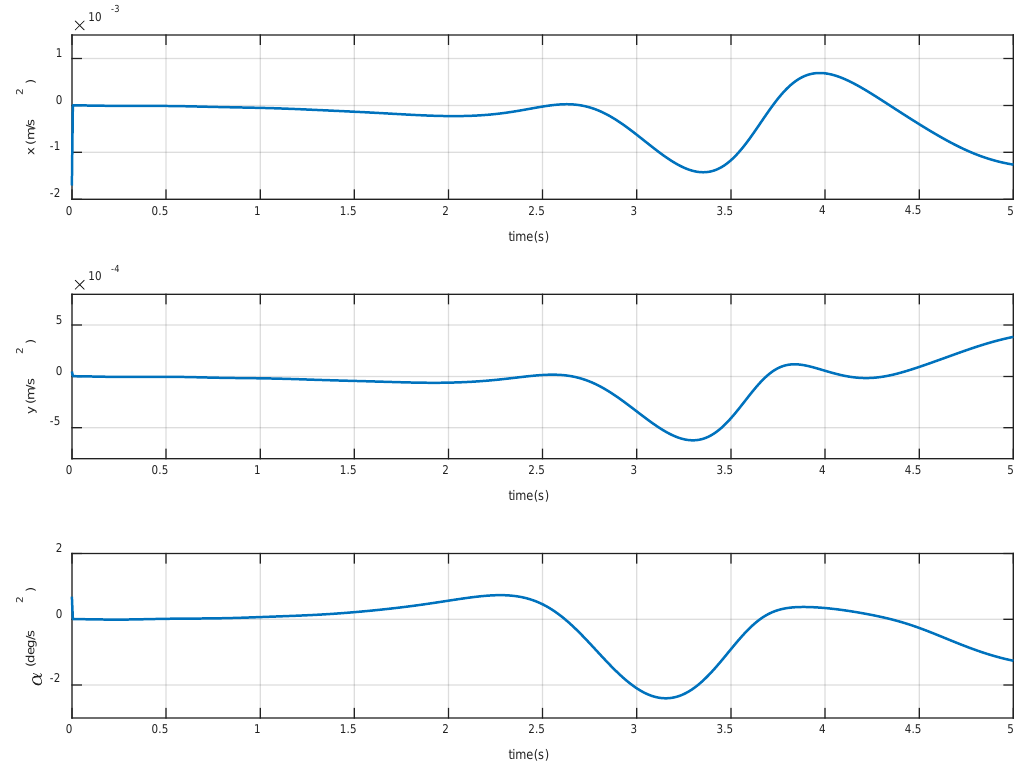
Figure 7. Errors of base acceleration and angular acceleration.